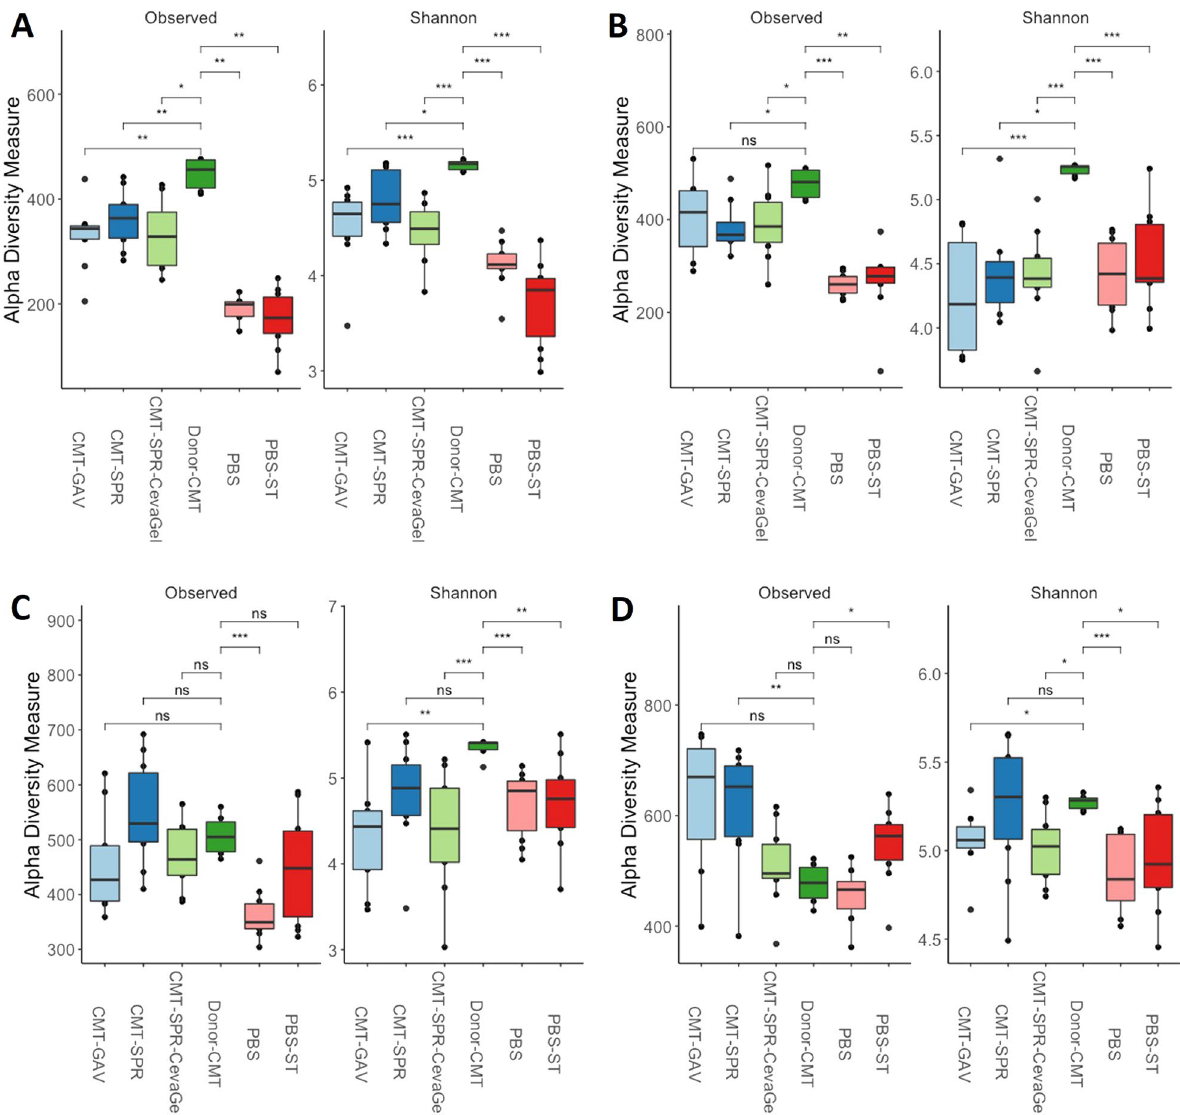
Fig. 5 Alpha diversity measures comparing route effects on microbiome richness. Alpha diversity was measured using Observed and Shannon measures at a sequencing depth of 7000. A At 7dph the CMT transplant groups have comparable numbers of observed species and richness and are closer to the donor material than the PBS groups, but the donor material still has more species and greater richness than all the experiment groups. B – D From 3 to 14-dpi the alpha diversity of the CMT groups compared to the PBS groups does not have as distinct differences as in the timing experiment. Species richness between the groups is comparable and up to 14-dpi is significantly lower than that of the donor material. * P < 0.05, ** P < 0.01, *** P < 0.001, **** P < 0.0001 as determined by Wilcoxon non-parametric